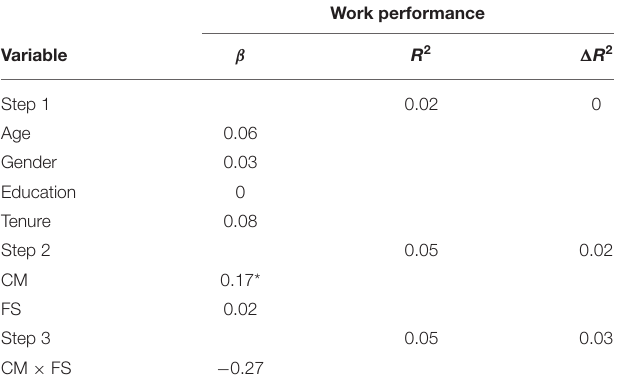
TABLE 4 | Hierarchical regression analyses to assess the effect of financial stress (FS) in affecting the relationship between controlled motivation (CM) and work performance (WP).